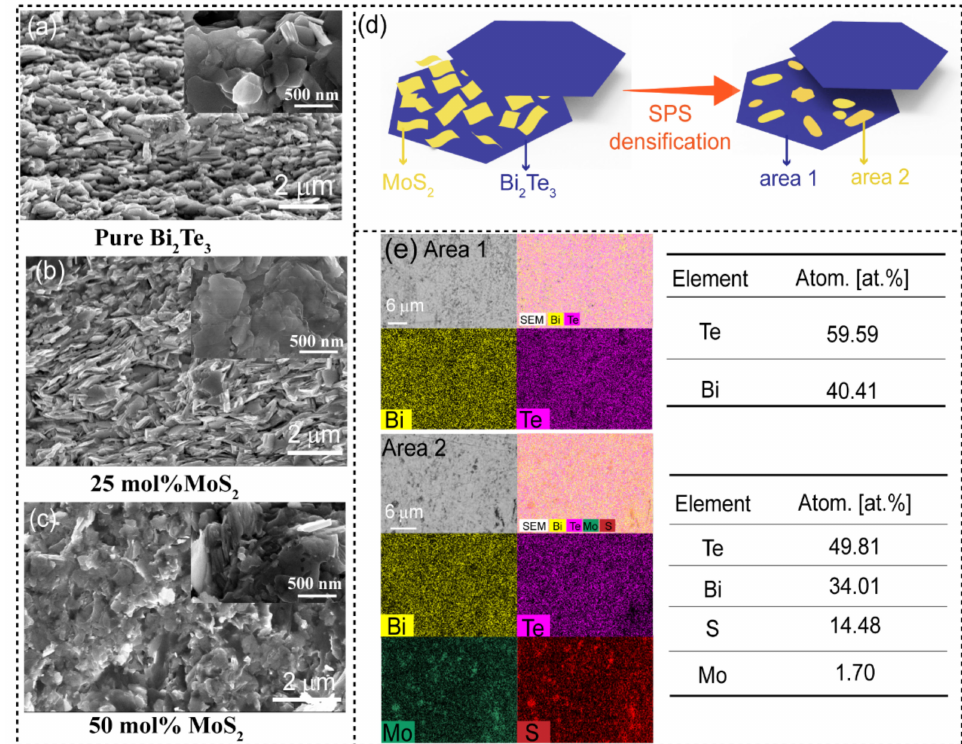
Figure 2. Fracture surface SEM images of Bi 2 Te 3 /X mol% MoS 2 after spark plasma sintering with ( a ) X = 0, ( b ) X = 25, and ( c ) X = 50; the insets correspond to the higher magnification images of the fracture surfaces; ( d ) schematic depiction of Bi 2 Te 3 /MoS 2 heterostructure before and after SPS; and ( e ) representative elemental mapping of two distinct areas of the X = 25 sample with their correspond- ing atomic